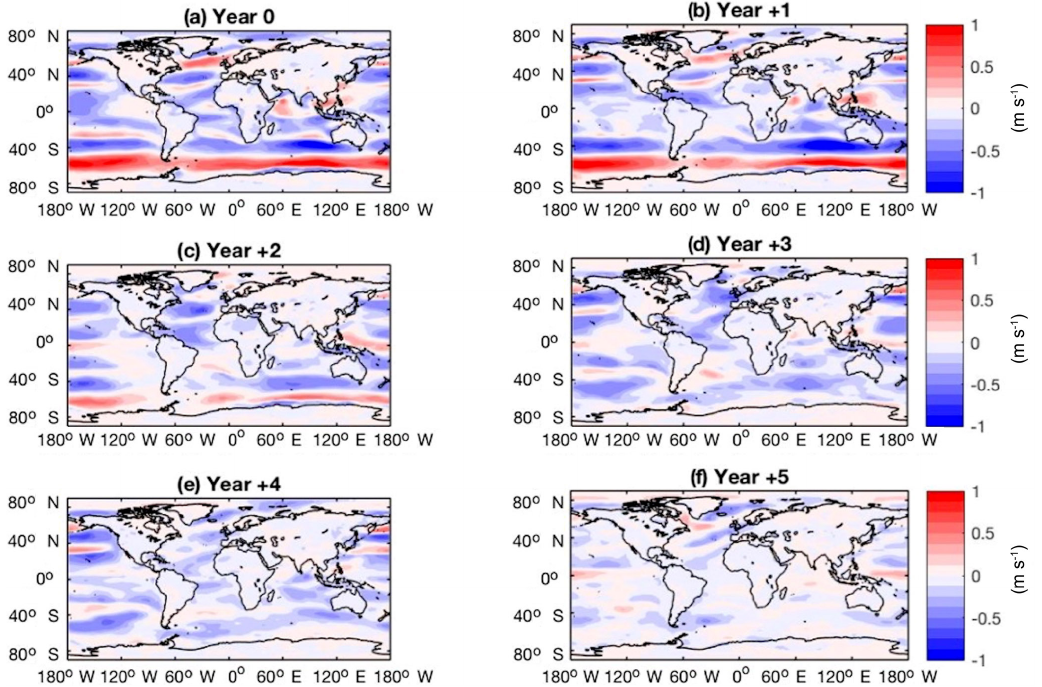
Figure 14. Global surface wind speed (ms − 1 ) anomalies in response to the Crowley and Unterman (CR) forcing, showing multi-ensemble mean responses over JASON averaged across all analysed eruptions for years 0 to + 5 after